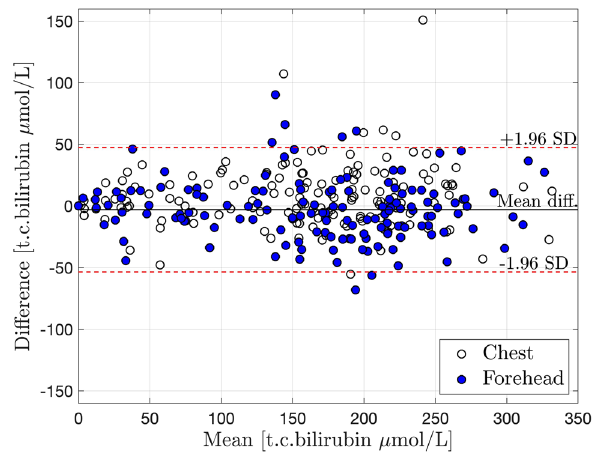
Figure 3. Bland–Altman plot with mean ± 2SD for an agreement between JM105 and JAISY measurements of t.c. bilirubin levels (μmol/L) in newborn infants. Unfilled circles = measurements at the chest, filled circles = measurements at the forehead. Mean = JM105 + JAISY/2. Difference = JM105 − JAISY.